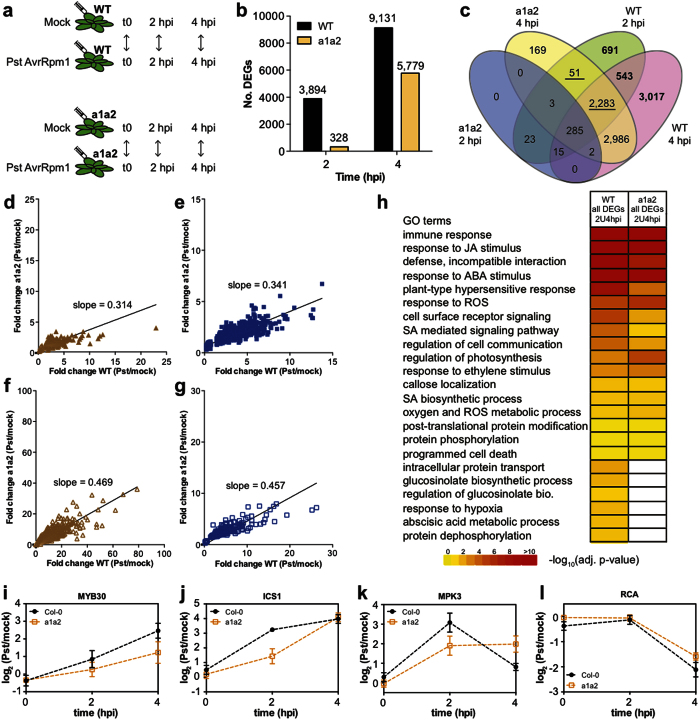
The response of ate1 ate2 mutant plants to Pst AvrRpm1 is altered.(a) Experimental design of the transcriptomics experiment performed to compare the gene expression changes in wild-type and ate1 ate2 (a1a2) plants following inoculation with Pst AvrRpm1. For each biological replicate, 4 plants of each genotype (4 leaves per plant) were inoculated with a suspension of Pst AvrRpm1 (5 × 107 cfu/mL) or a mock solution. Whole leaves were collected at t0, 2 hpi and 4 hpi. Four independent experiments with dye swaps were carried out for gene expression analysis. (b) Number of differentially expressed genes identified at 2 hpi and 4 hpi in wild-type (WT) and in ate1 ate2 (a1a2) plants. Differentially expressed genes were identified based on |log2(fold change)| > 0.5 and a corrected P-value < 0.01. (c) Venn diagram indicating the overlap between the different datasets obtained in this study. The number of genes is indicated on the diagram. (d,e) Comparison of the gene expression differences observed in the ate1 ate2 mutant and in wild-type plants for genes that were only called as differentially expressed in the wild type at 2 hpi (d) and 4 hpi (e). (f,g) Comparison of the gene expression differences observed in the ate1 ate2 mutant and in wild-type plants for genes that were judged as differentially expressed in both genotypes at 2 hpi (f) and 4 hpi (g). The slopes in panels (d–g) were obtained by linear regression. (h) Selected GO terms identified to be enriched among DEGs in wild-type and ate1 ate2 plants following inoculation with Pst AvrRpm1. For this analysis, the union of the datasets obtained at 2 hpi and 4 hpi was considered for each genotype. Adjusted P-values are represented through color-coding. (i–l) Gene expression changes for MYB30 (i), ISOCHORISMATE SYNTHASE1 (ICS1) (j), MPK3 (k) and RUBISCO ACTIVASE (RCA) (l) in wild-type and ate1 ate2 plants in response to Pst AvrRpm1. Effects on gene expression were measured by RT-qPCR using tissue inoculated with a mock solution or with a suspension of Pst AvrRpm1 at a density of 5 × 107 cfu/mL. Error bars indicate SEM of four independent experiments.